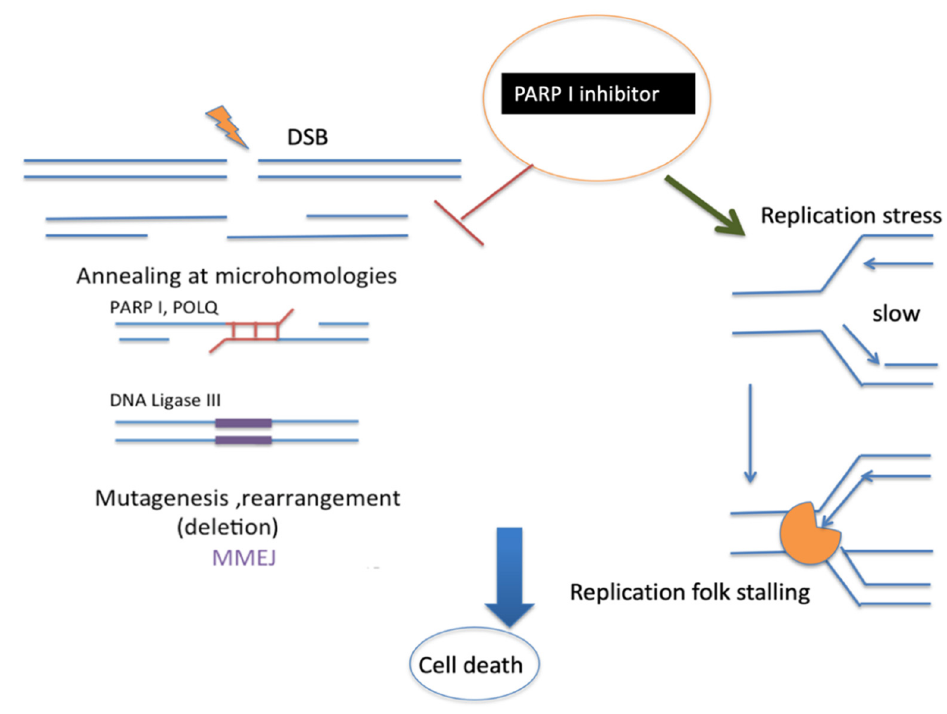
Figure 5. Proposed mechanism of PARP1 inhibitor. PARP1 is well known to promote MMEJ at the early stage. This is followed by POLQ and DNA ligase III activity. PARP1 inhibitors can also stabilize replication fork stalling [98] with polymerase (orange). Both mechanisms of PARP1 inhibition could induce cancer cell death.